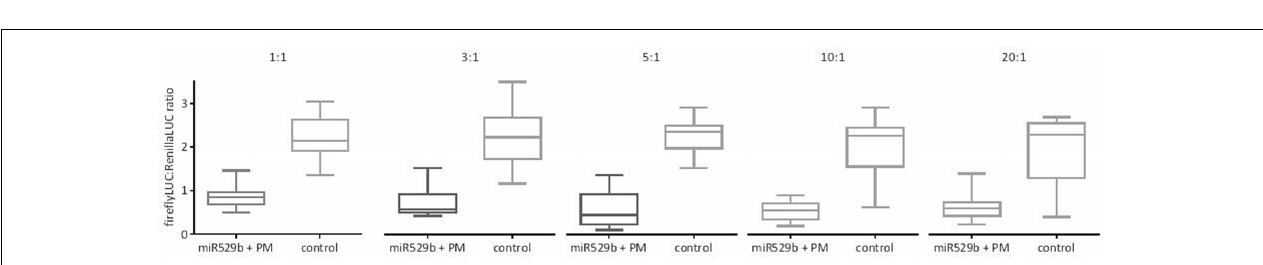
FIGURE 4 | miR529b-mediated repression of perfectly matching (PM) target reporter gene expression in transient co-agroinfiltration assays with different precursor culture to target culture ratios. The controls consist of assays where the miR529b precursor culture was replaced with a precursor construct culture that does not target the miR529b PM sequence. The results are depicted as box and whisker plots, with interquartile range boxes and min/max whiskers ( n = 12).